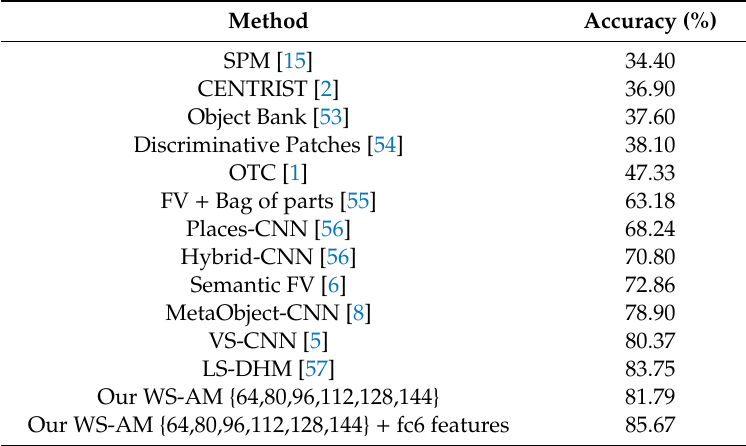
Table 2. Accuracy comparison on MIT indoor 67